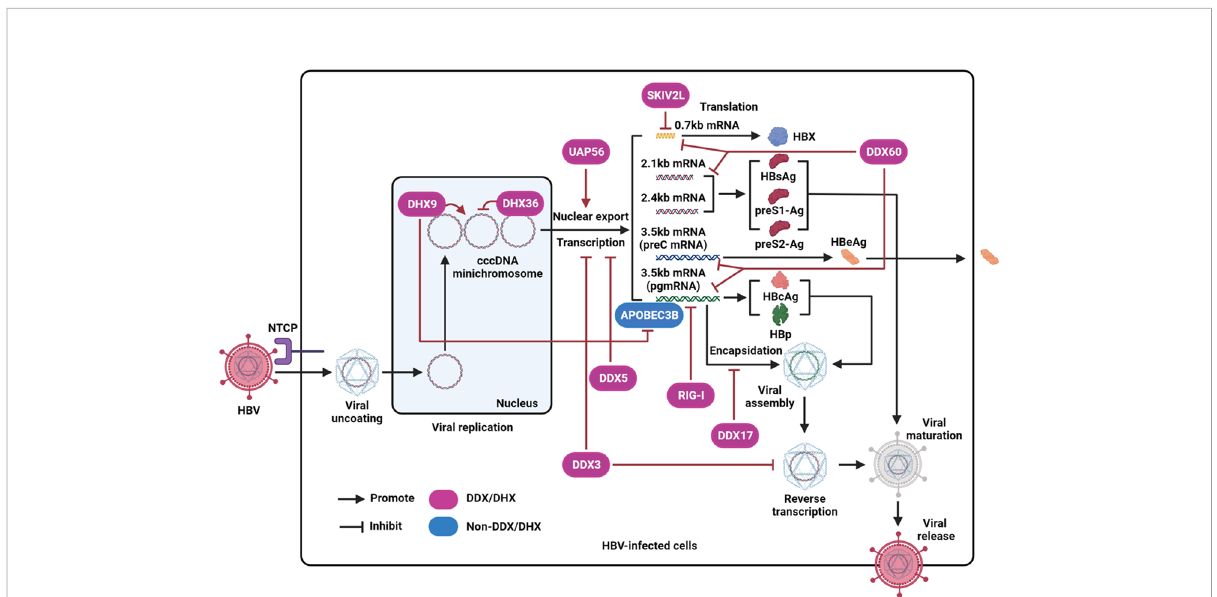
FIGURE 1 The effect of DEAD/H-box helicases on the regulation of HBV by disrupting different steps of the viral life cycle. After interacting with NTCP and entering host cells, the virus is uncoated and then transferred into the nucleus. Next, the HBV genome is converted into cccDNA, forms a mini- chromosome, and is further transcribed into various viral mRNA, including pregenomic RNA (pgRNA) (3.5kb), preC mRNA (3.5kb), two envelope mRNAs (2.1kb and 2.4kb), and X mRNA (0.7kb). The pgRNA is a translation template for viral polymerase proteins (HBp) and HBcAg. The preC mRNA encodes HBeAg antigen. The two envelope mRNAs encode HBsAg, preS1-Ag, and preS2-Ag. X mRNA codes HBX protein. Then, pgRNA is encapsulated into viral particles and further reverse-transcribed into DNA. Finally, intact viral particles are secreted from liver cells. RIG-I represses HBV pgRNA. DDX60 facilitates the degradation of HBV RNA. DDX3 inhibits the transcription of viral cccDNA and suppresses viral reverse transcription. SKIV2L is capable of degrading HBX mRNA. DDX5 inhibits HBV transcription. DHX9 promotes viral DNA replication, interacts with and inhibits the binding of APOBEC3B to viral pgRNA. DHX36 interacts with the G-quadruplex structure of HBV cccDNA. DDX17 interacts with HBV pgRNA to restrain its encapsidation. UAP56 could facilitate the nuclear export of HBV